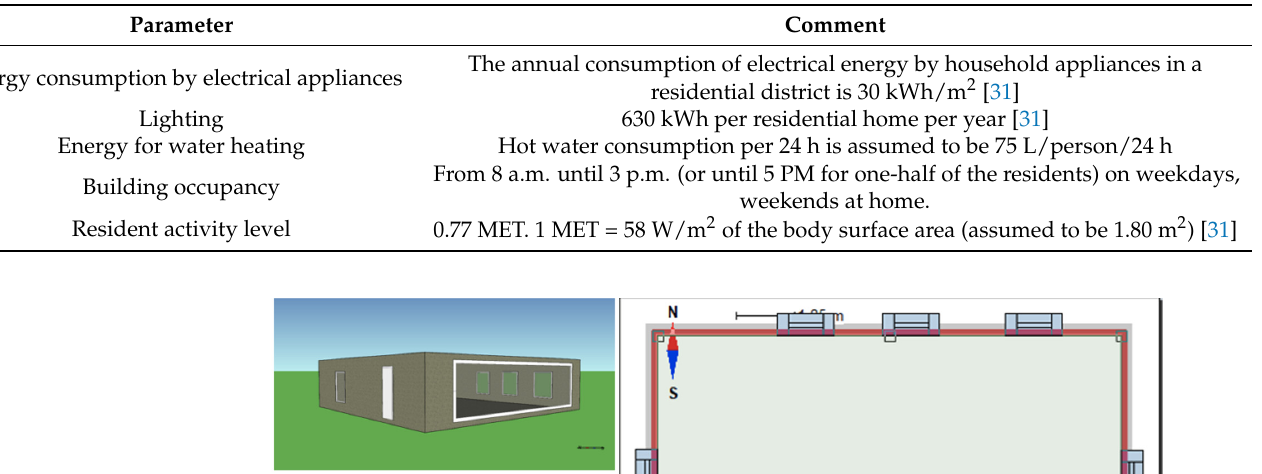
Table 6. Building usage parameters.